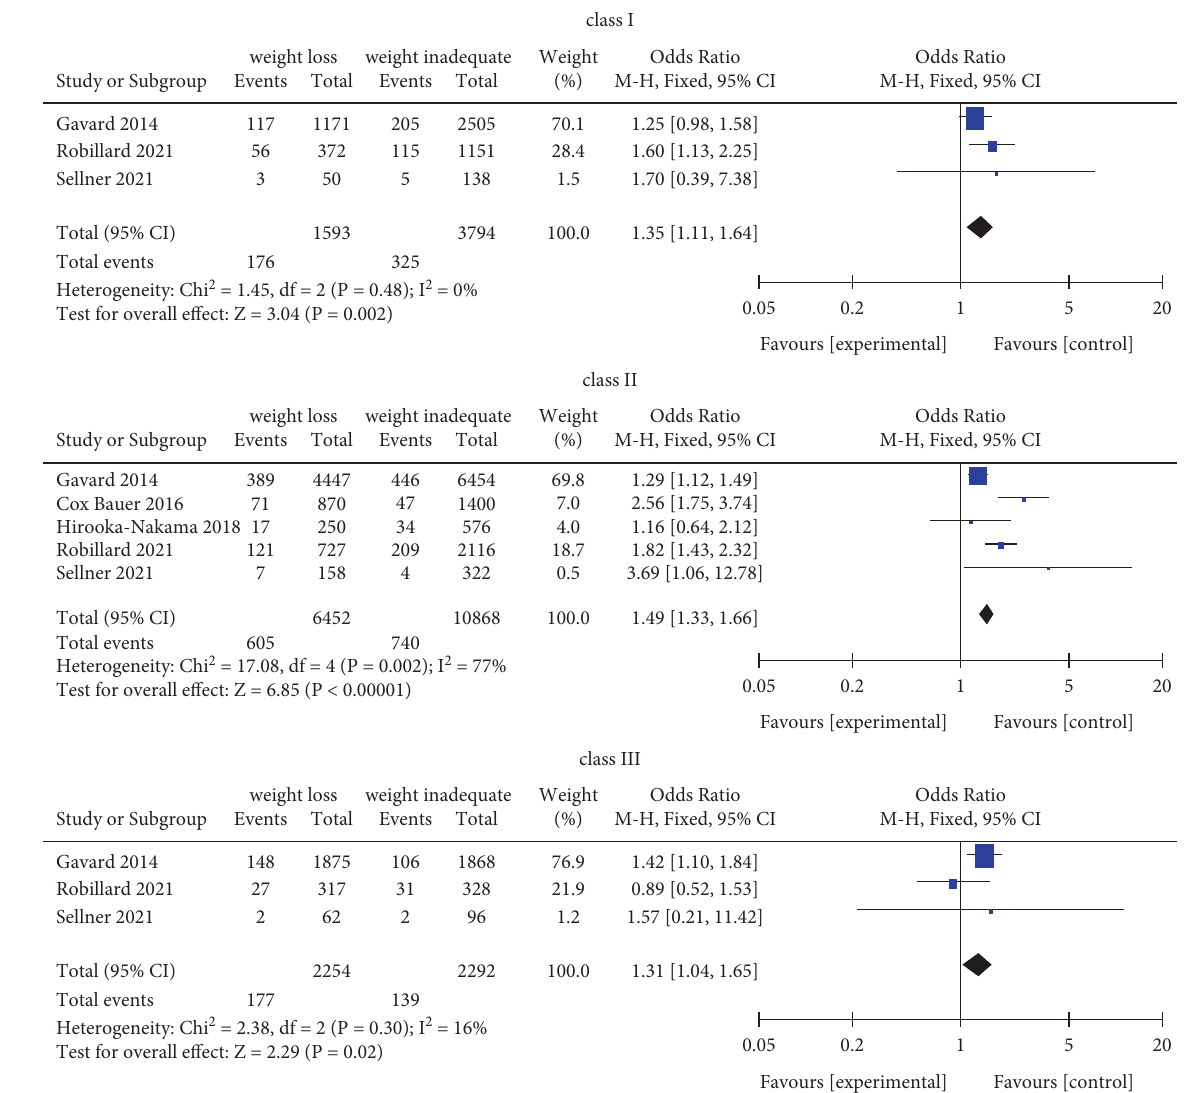
Figure 8: Forest plot of weight loss and inadequate weight with SGA for obese women of each class